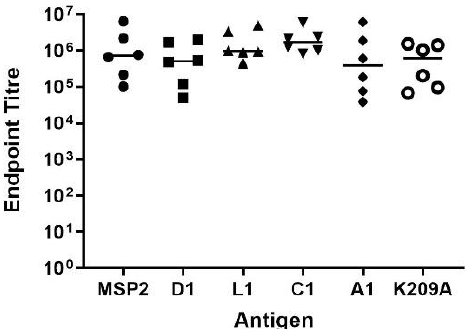
Figure 4. Mouse sera, taken two weeks after final immunisation with antigen, contain antibodies that recognise their corresponding peptide-BSA conjugate or in the case of the MSP2 mix, recombinant 3D7 and FC27 MSP2 coated on the ELISA plate. Each point is the mean of two replicate wells for individual mouse sera. The line indicates group median. Endpoint titre was calculated using a cut-off value of three standard deviations greater than OD 405 for naïve mouse serum (~0.09).